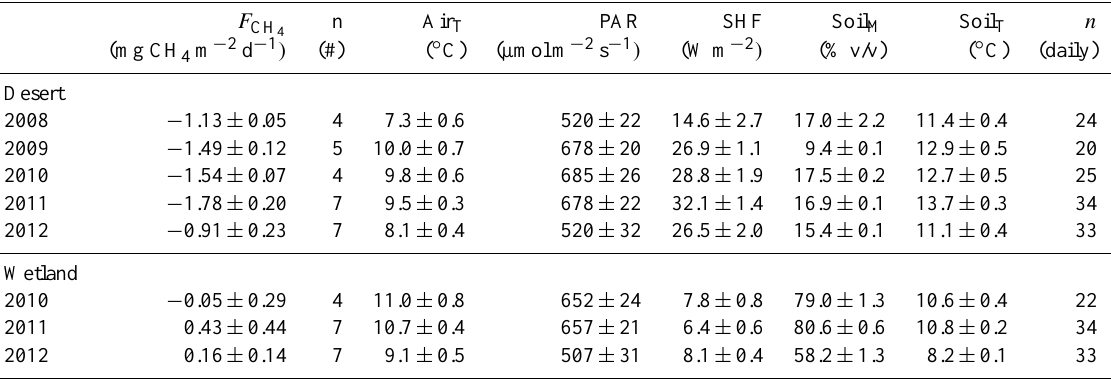
Table 1. Mean ( ± 1SE) daily CH 4 flux ( F CH seasons at the desert and wetland